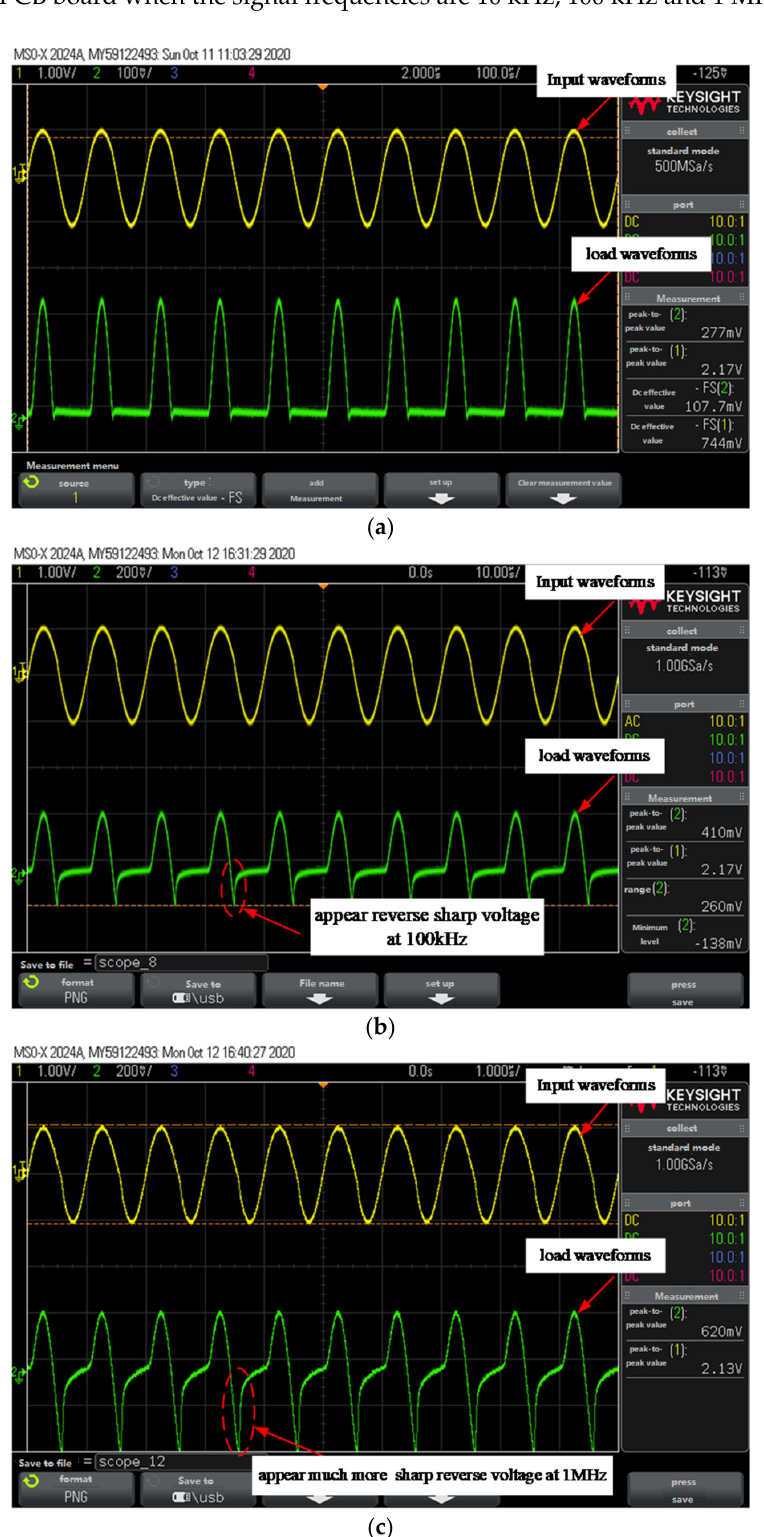
Figure 18. Experimental test results: ( a ) Input and load waveforms of 10 kHz excitation; ( b ) Input and load waveforms of 100 kHz excitation; ( c ) Input and load shape of 1 MHz excitation.